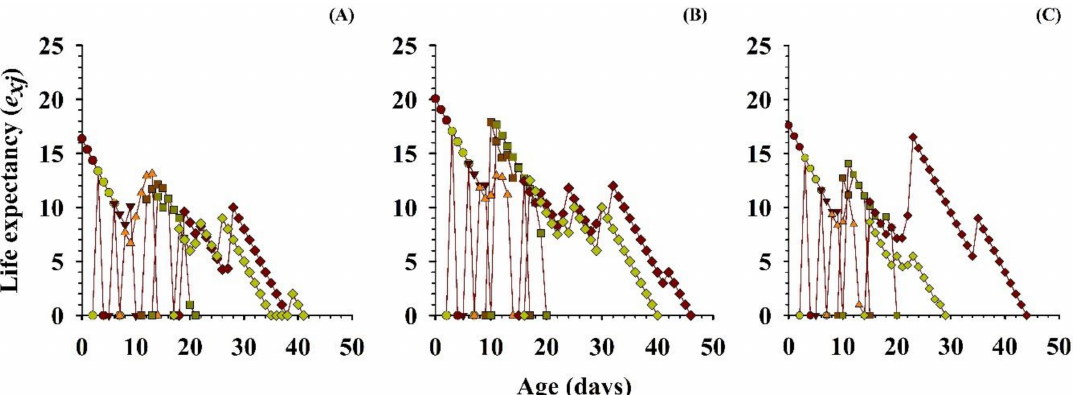
Figure 6. Influence of three di ff erent densities of P. gossypiella eggs (( A ) = 5 eggs, ( B ) = 10 eggs and ( C ) = 15 eggs) on the age-stage-specific life expectancy ( e